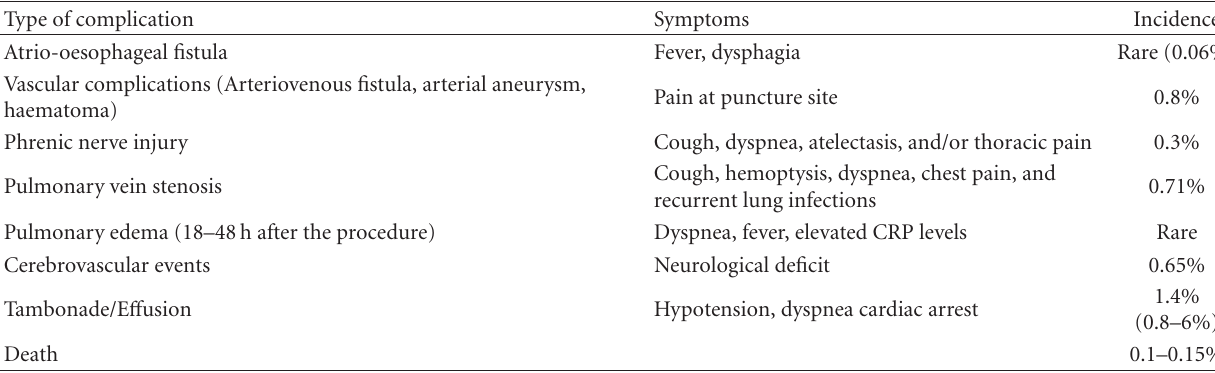
Table 1: Complications during catheter ablation of persistent and long-standing persistent